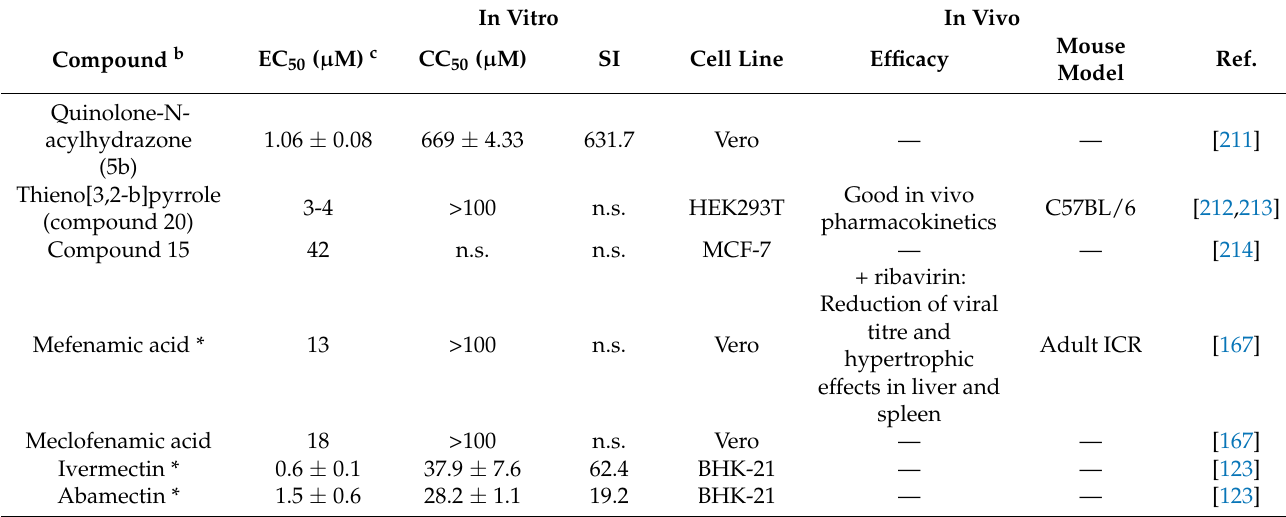
Table 4. Antiviral compounds without a known target a